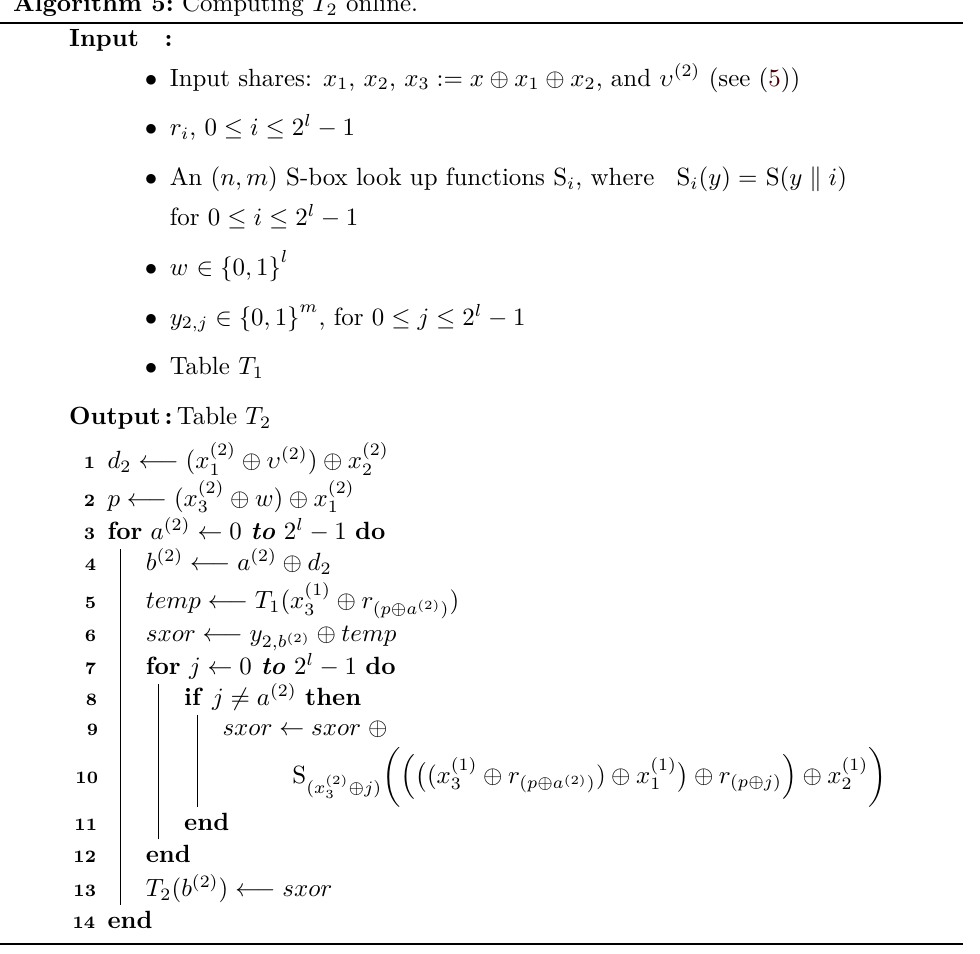
Algorithm 5: Computing T 2